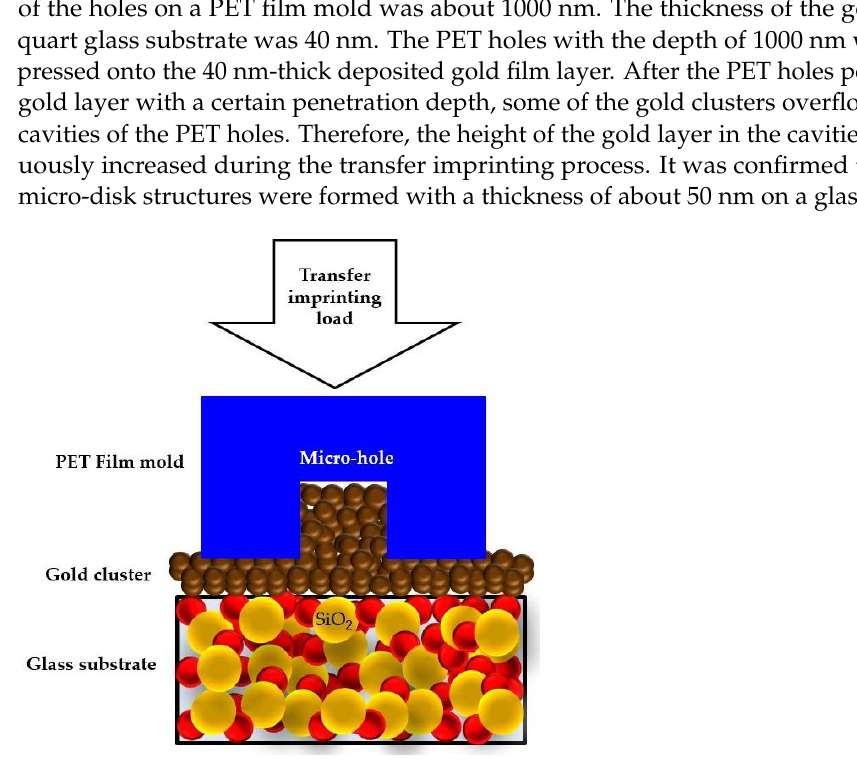
Figure 10. The schematic diagram of the compression mechanism for the transfer imprinting pro- cess.